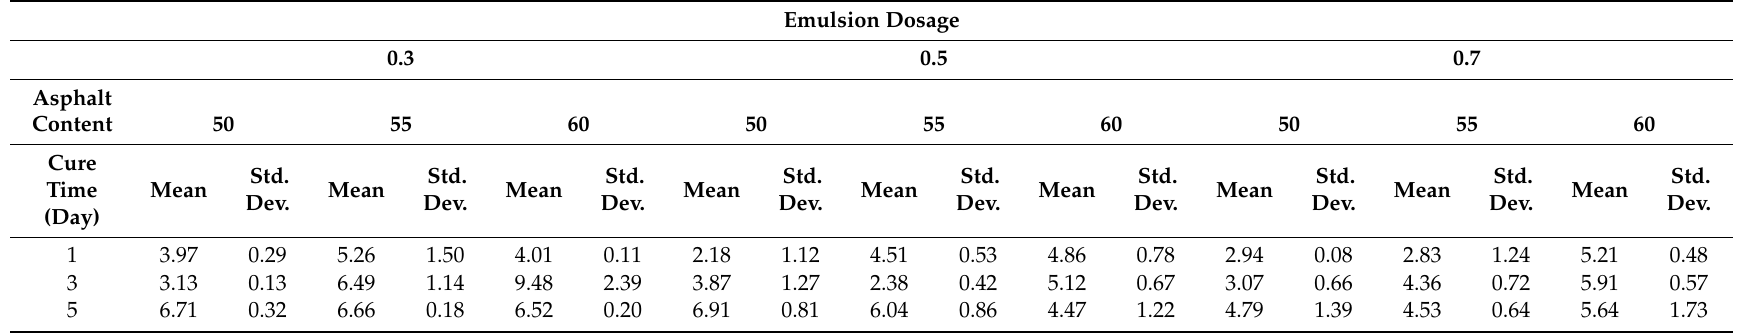
Table 3. Summary statistics for the fracture energy (J / m 2 ) of the rapid setting asphalt emulsions for the three doses and cure times.